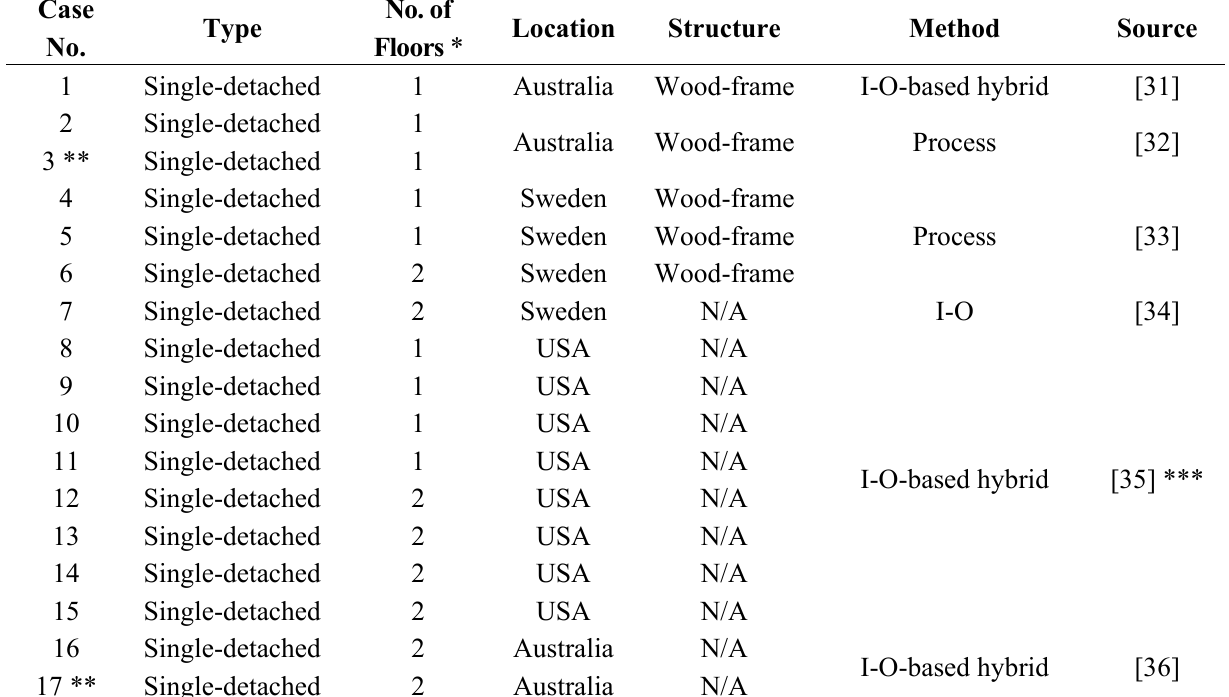
Table 4. Overview of literature on embodied energy (EE) of low-rise residential buildings.